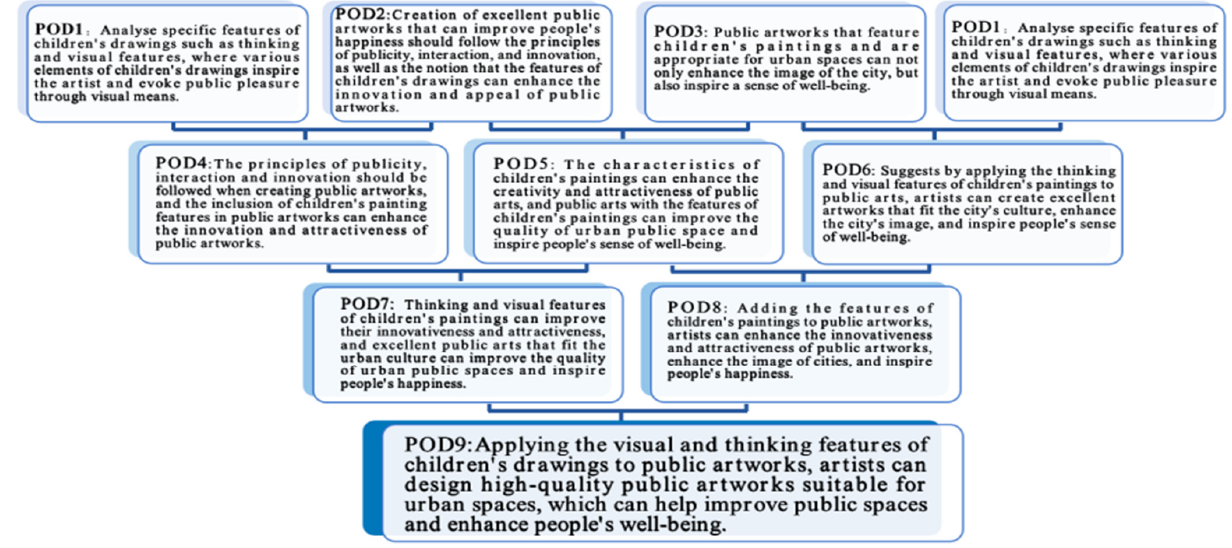
Figure 9. Point of Departure (POD) Tree Diagram for the impact of public artworks on public space and people’s happiness. Adapted with permission from [9]. Copyright 2018, Ibrahim and Mustafa Kamal.